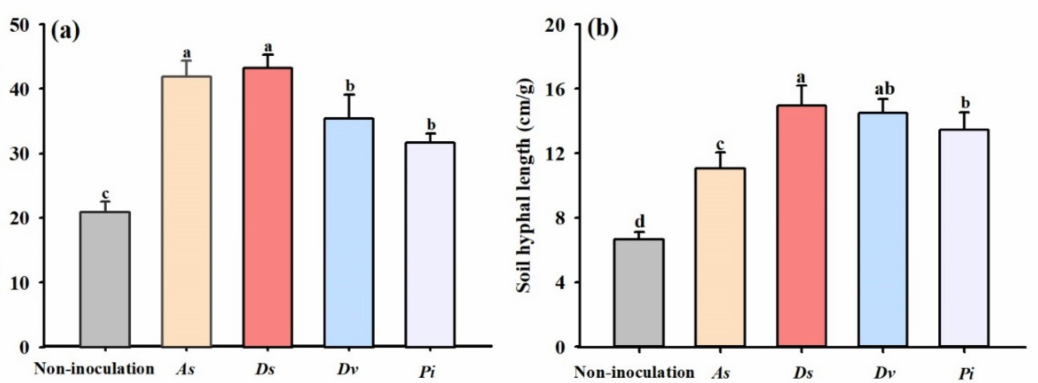
Figure 1. The effect of inoculation with Acaulospora scrobiculata ( As ), Diversispora spurca ( Ds ), D. ver- siformis ( Dv ), and Piriformospora indica ( Pi ) on the root fungal colonization rate ( a ) and soil hyphal length ( b ) of the lane late navel orange trees. Data (means ± SD, n = 4) are significantly ( p < 0.05) different if followed by different letters above the